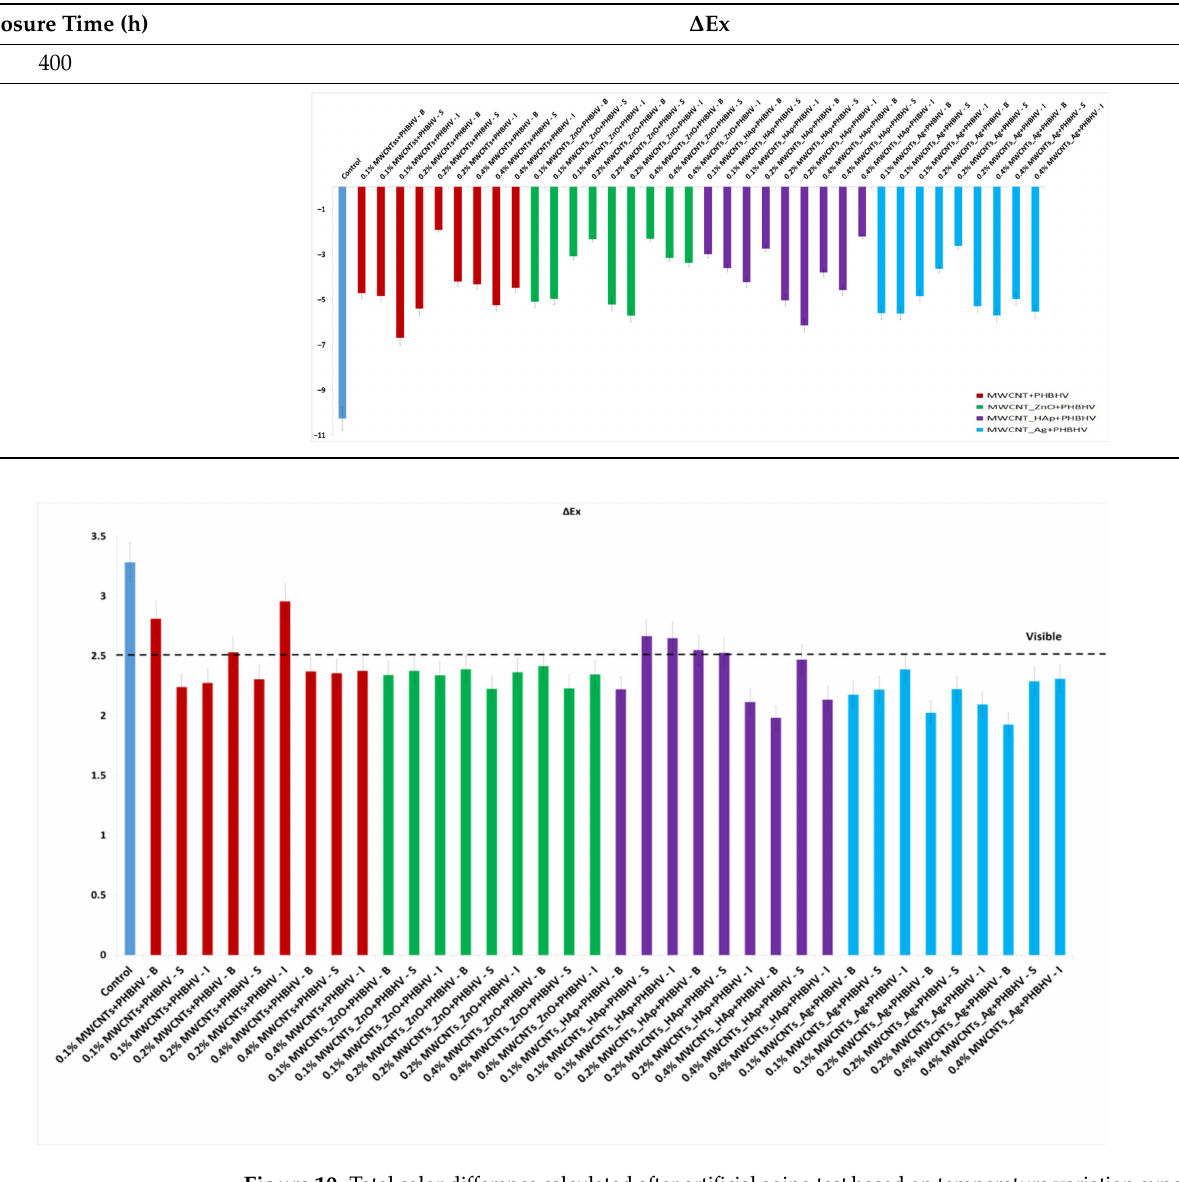
Figure 10. Total color difference calculated after artificial aging test based on temperature variation exposure.